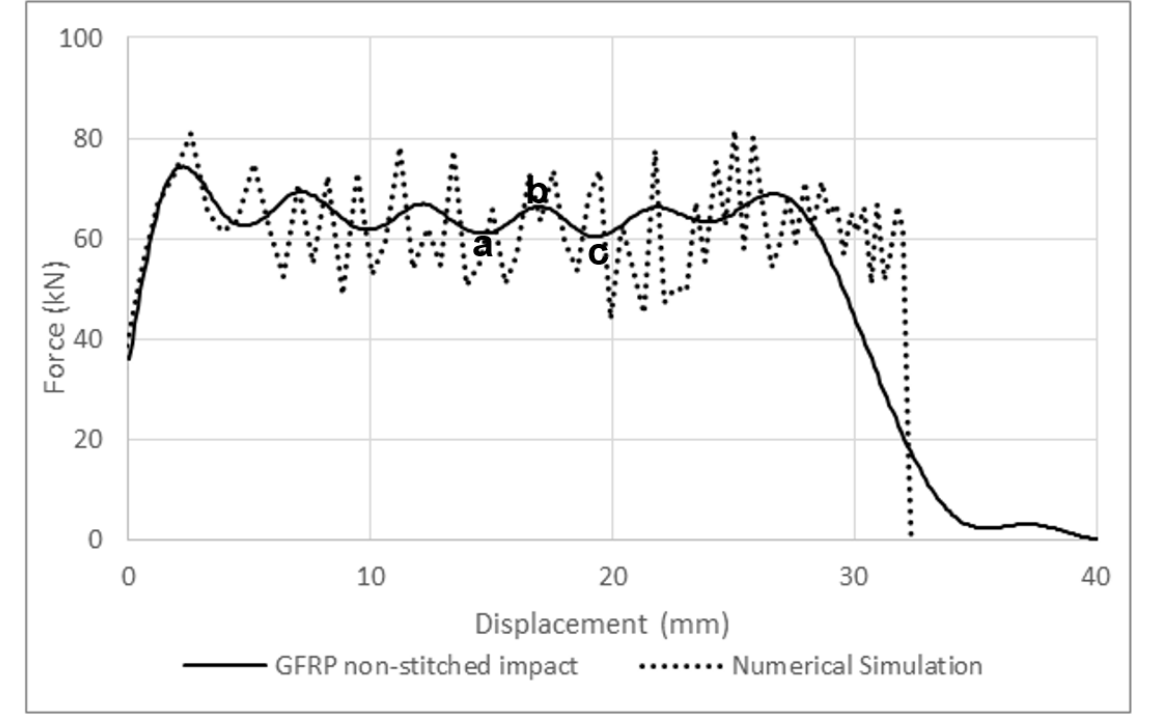
Figure 26. Force – displacement characteristic experimental and numerical comparison [66], (a – b) in- Figure 26. Force–displacement characteristic experimental and numerical comparison [66], (a–b) in- crease in load and(b – c) decrease in load. crease in load and(b–c) decrease in